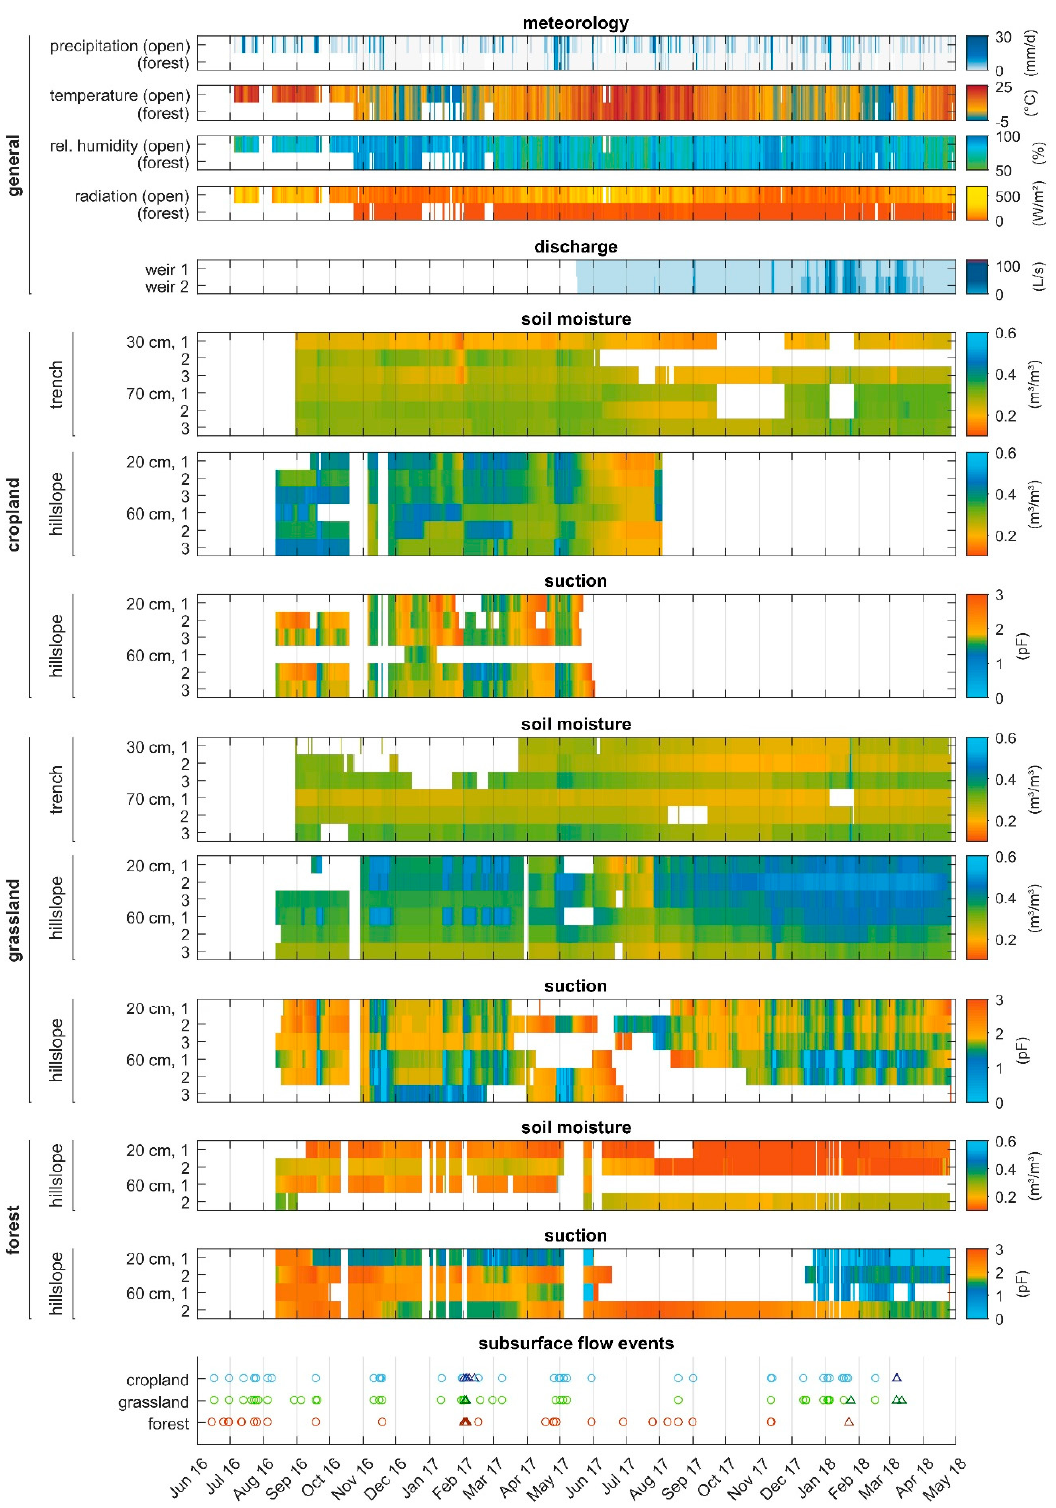
Figure 3. Overview of the continuously measured parameters at the hillslope to characterize subsurface flow events: precipitation, temperature, relative humidity, radiation, hillslope discharge, soil moisture, and suction. Subsurface flow events are divided into rain-induced events (o) and thawing events ( ∆ ). Meteorological conditions are given for the open area (upper line) and the forest (lower line). The lines of soil moisture and suction measurements indicate the segments (trench) and the positions (hillslope) according to Figure 1 and Figure 2.